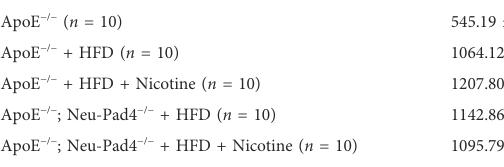
Total cholesterol